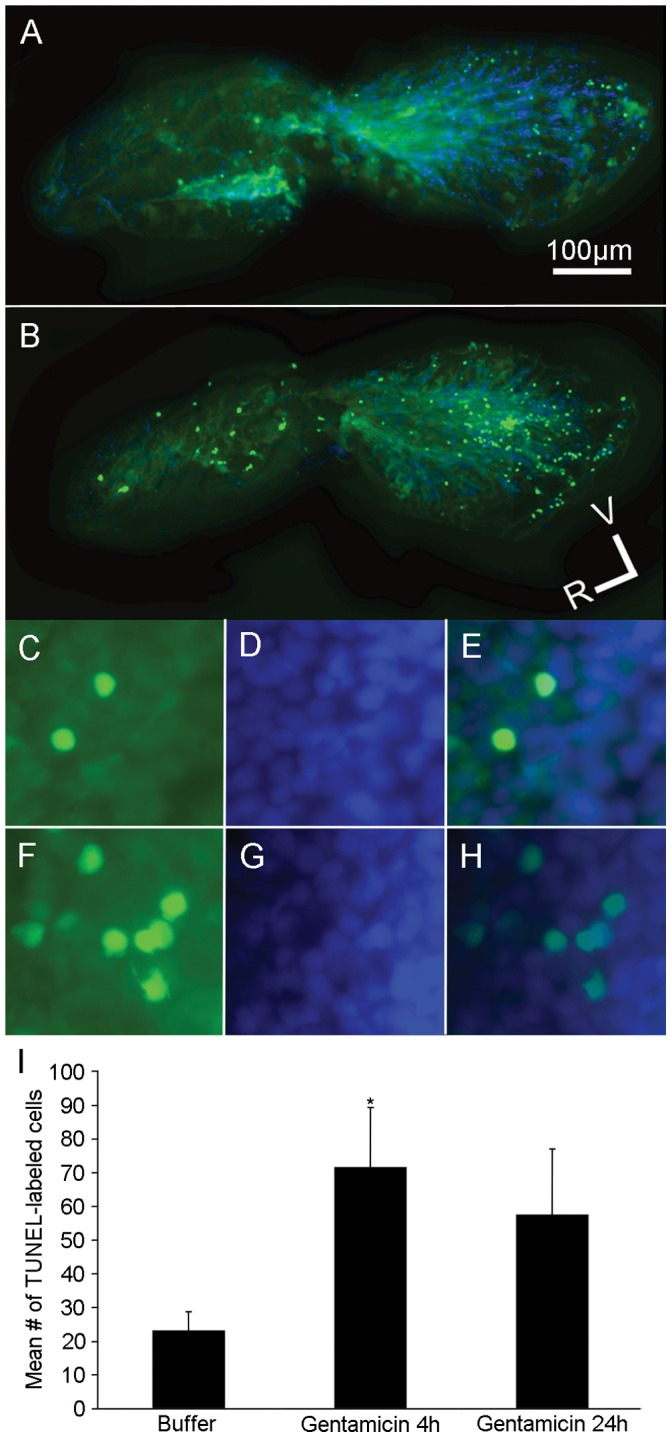
Gentamicin treatment increases the numbers of TUNEL-labeled cells in the adult saccule.Adult wildtype zebrafish received either a single intraperitoneal injection of (A, C, D, E) buffer or (B, F, G, H) 250 mg/kg gentamicin and allowed to recover for either 4 or 24 hours (4 hour data is shown). Fixed saccules were processed using a TUNEL-kit to label apoptotic cells (green cells; A, B, C, E, F, H) and co-labeled with DAPI (blue cells; A, B, D, E, G, H). (A-B) Low power and (C–H) high power images of the saccule reveals few TUNEL-labeled cells scattered throughout the saccule of a buffer-treated animal (A, C, E) but more TUNEL-labeling in a gentamicin-treated animal (B, F, H). (I) Mean number of TUNEL-labeled cells (± SD) in the saccules of buffer- or gentamicin-injected zebrafish. *p<0.05; n = 9–12; V = ventral, R = rostral.